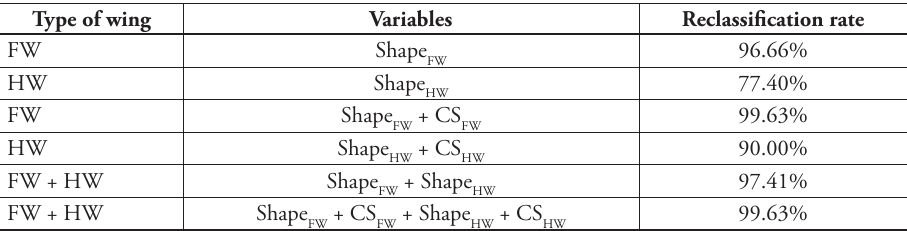
Figure 4. Extreme shape differences between Apis mellifera intermissa , A. m. sahariensis and A. m. capensis along the first two canonical variates (Fig. 3A, B). A and B fore wing shape differences along the first and second canonical variate, respectively. C and D hind wing shape differences along the first and second canonical variate, respectively (scale factor ×3 and ×2 respectively). Grey lines depict the shape associated with the negative values and black lines the shape associated with the positive values of the respective canonical Table 2. Reclassifications results at the subspecies level: A. m. intermissa , A. m. sahariensis , and A. m. capensis (always n = 90).